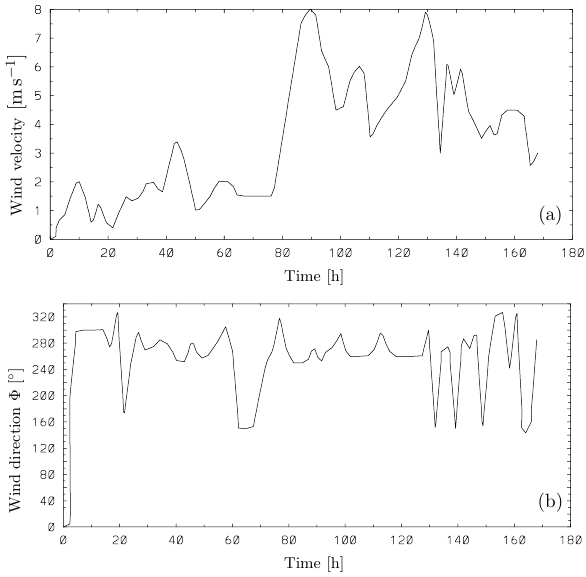
FIG. 22: Measured wind speed (a) 4.4 m above the lake surface at the station “Boje Mitte” (approximately at the center of the ¨Uberlinger See) from 16.2.’93 0 00 MET until 22.2.’93 24 00 MET, and direction (b) of which the mean value is approximately 270 ◦ (West). FIG. 23: a) Flow velocity at 80 m depth near the Mainauschwelle subject to the wind forcing displayed in Fig. 22. The solid curve indicates the measured values, the broken curve corresponds to the computational result. b) Same as a) but for the flow direction. Its value after the wind set-up is approximately toward 320 ◦ (northwest).